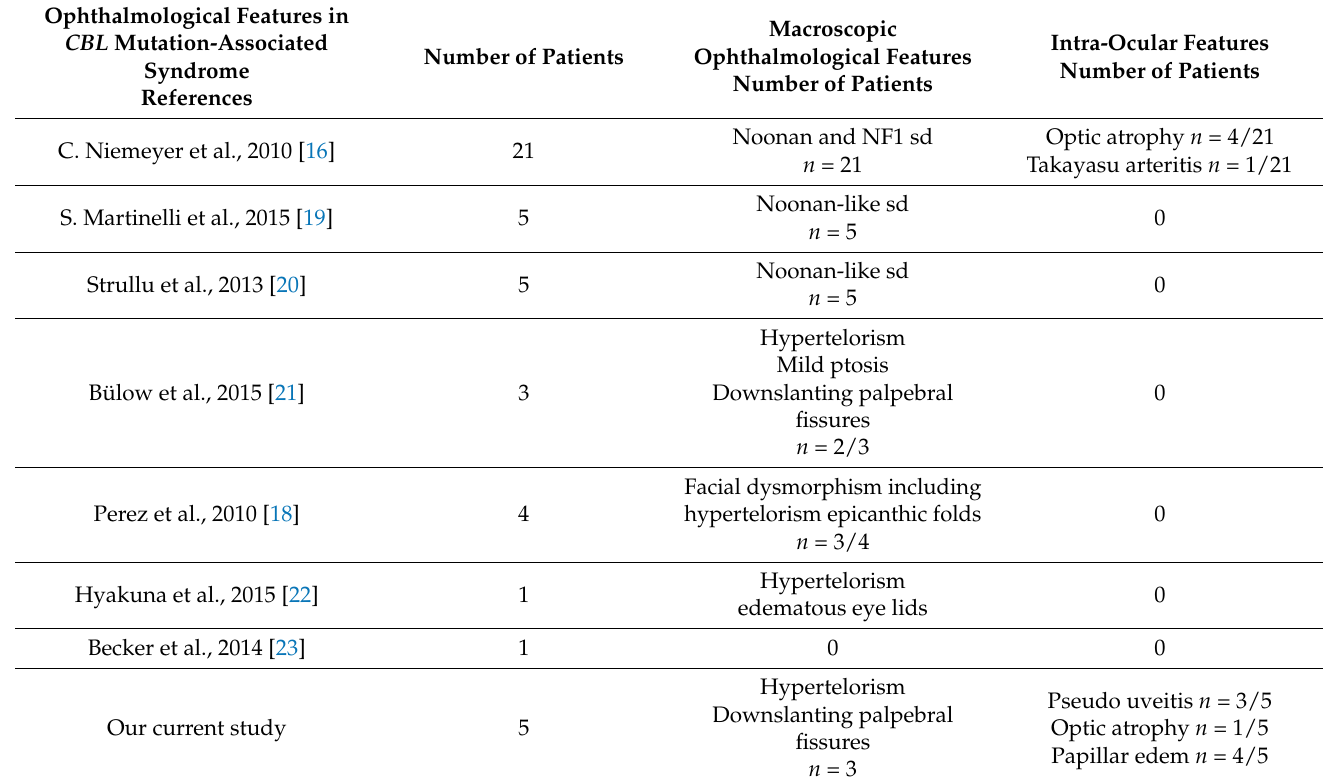
Table 2. Summary table of studies included in